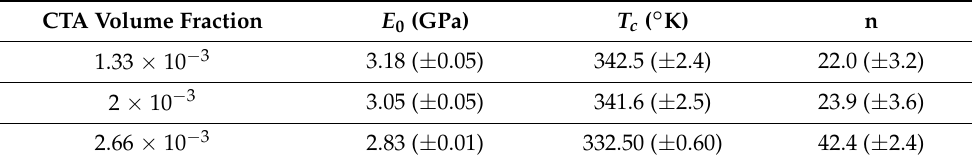
Table 1. Parameters determined from fitting the Young’s modulus data to Equation (32) for the three CTA volume